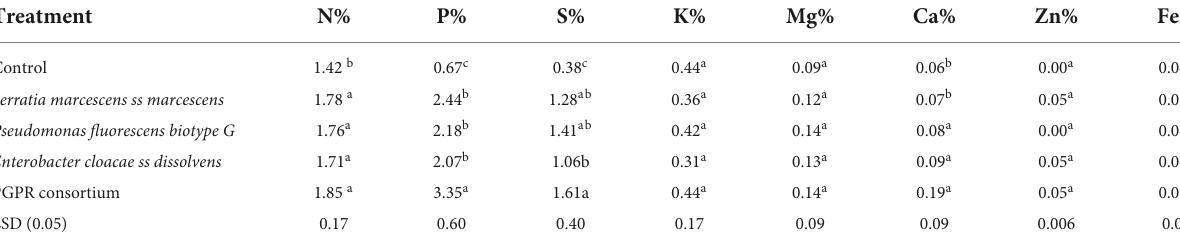
TABLE 6 Individual treatment means PGPR inoculation on teff grain nutrient content improvement.